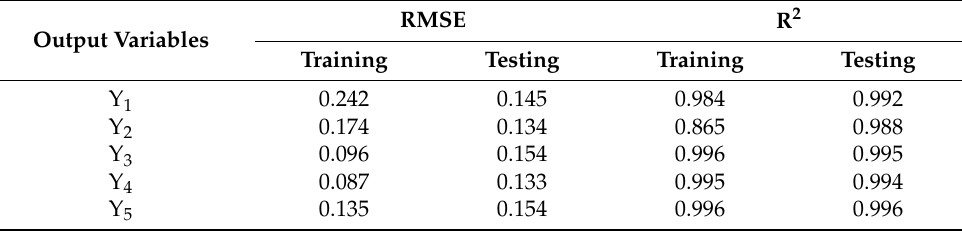
Table 4. Root-mean-square error (RMSE) and R 2 values for volumetric and physical properties of basalt fibre reinforced asphalt mixture. RMSE R Output Variables